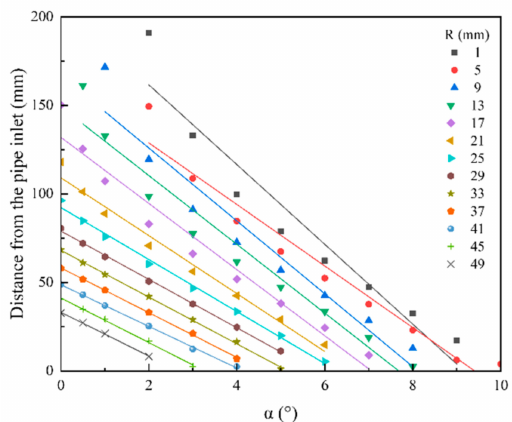
Figure 12. Variation of deposition distance from the pipe inlet of ions with emission angle α under the characteristic magnetic flux density of 1840 Gs.